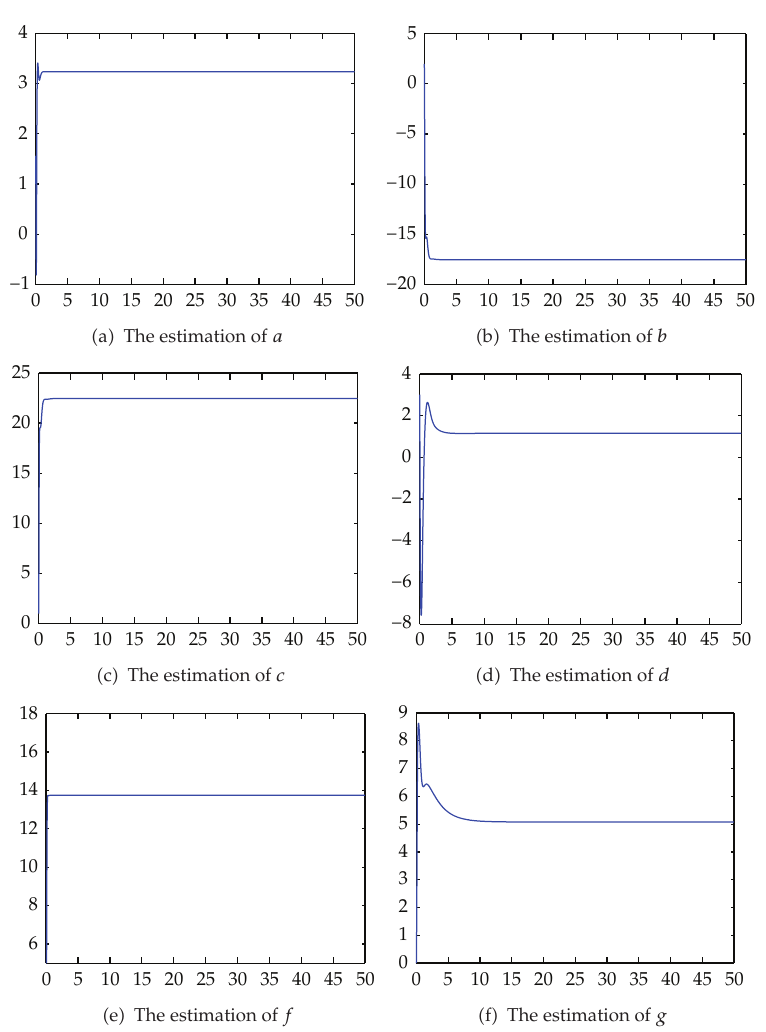
(cid:6) b is the estimation of